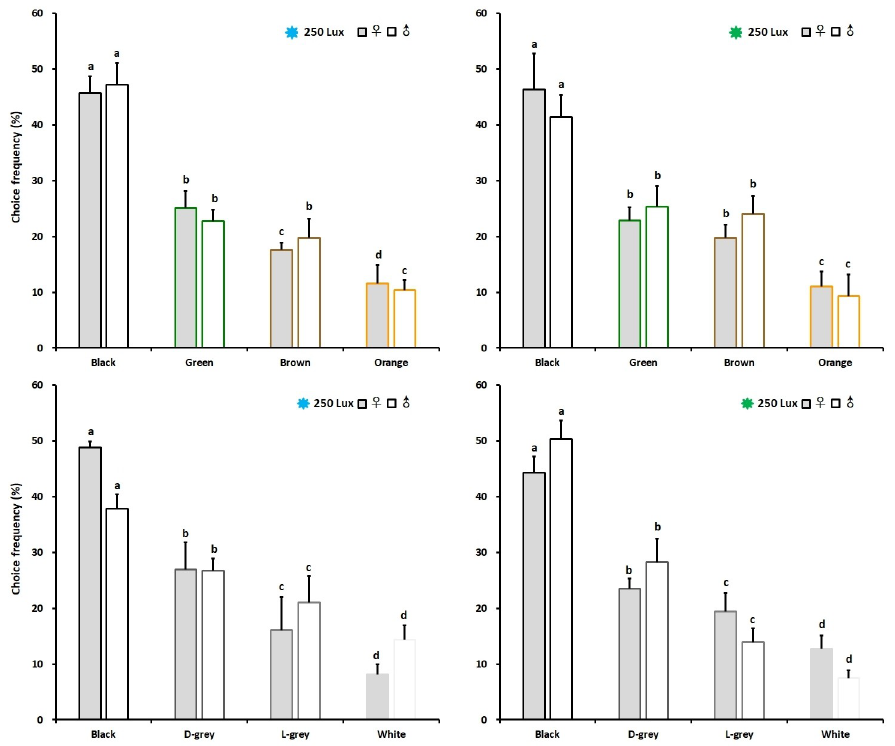
Fig 5. Colour hues and brightness preference of chive gnat Bradysia odoriphaga adults under two spectrally different illuminations. Colour choice among four colour stimuli differing in hue under blue light (left) and green light (right) on the top. Choice among four colour stimuli differing in brightness under blue light (left) and green light (right) on the bottom. Different letters refer to significant differences according to One-way ANOVA with P < 0.05. 9.33% (Fig 5 Up). Moreover, the multiple choice among four levels of brightness (black, dark grey, light grey and white) under blue light of 250 lux intensity were used for testing the choice preference of the chive gnat adults. The adult females significantly preferred black with a per- centage of choice amounting to 48.82% over dark grey amounting to 26.97% as well as light grey and white amounting to 16.10 and 8.12%, respectively. the adult males, however, signifi- cantly preferred black with a percentage of choice amounting to 37.79% over dark grey amounting to 26.76% as well as light grey and white amounting to 21.07 and 14.38%. Under green light of 250 lux intensity the adult females significantly preferred black with a choice fre- quency amounting to 44.32% over dark grey, light grey and white amounting to 23.47, 19.47 and 12.74%, respectively. However, the male adults significantly preferred black with a choice frequency amounting to 50.31% over dark grey, light grey and white amounting to 28.22, 13.97 and 7.50%, respectively (Fig 5 Down). Experiment 3: Colour hues and brightness of chive gnat adults with different physiological state